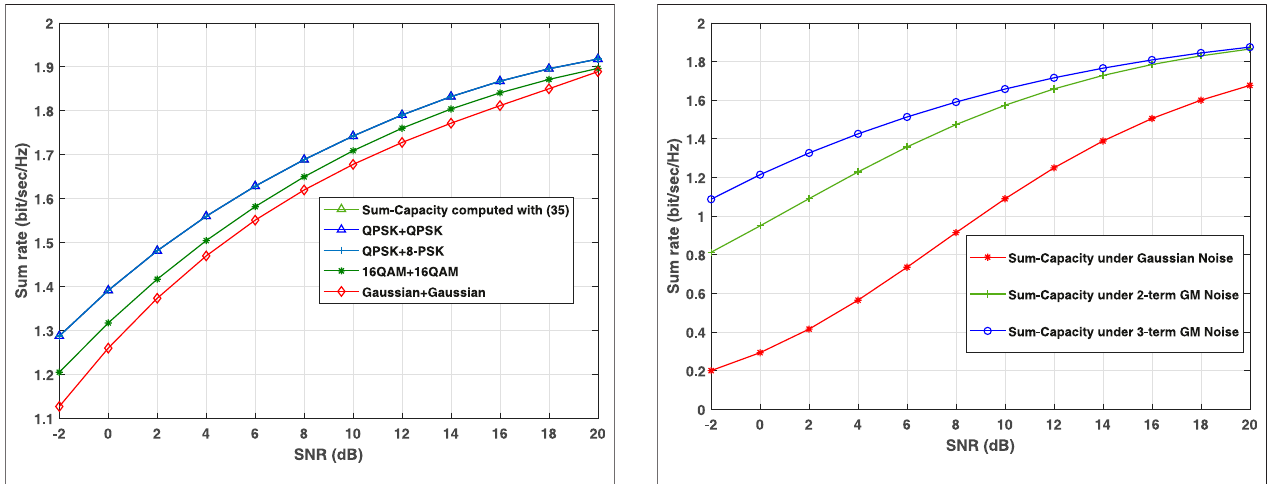
FIGURE 7 | Sum-capacities of MACs under different types of noise: Gaussian, 2-term GM, and 3-term